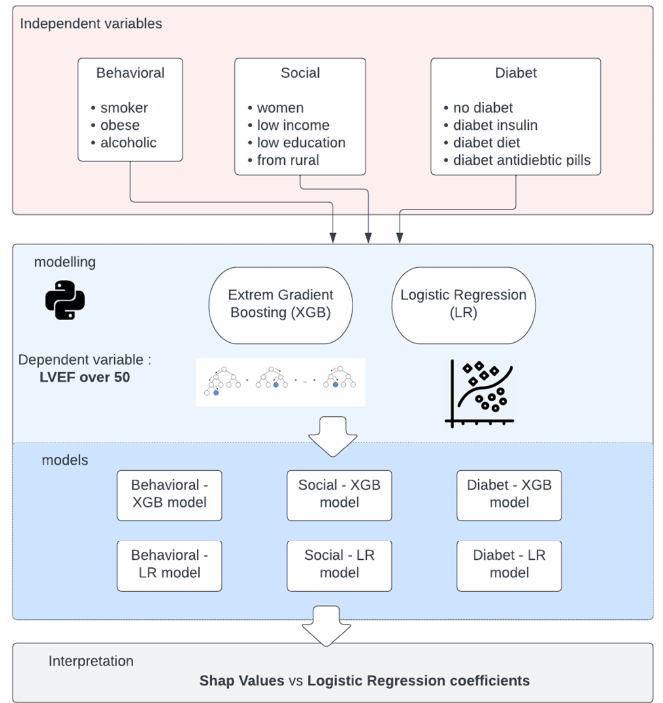
Figure 2. Research